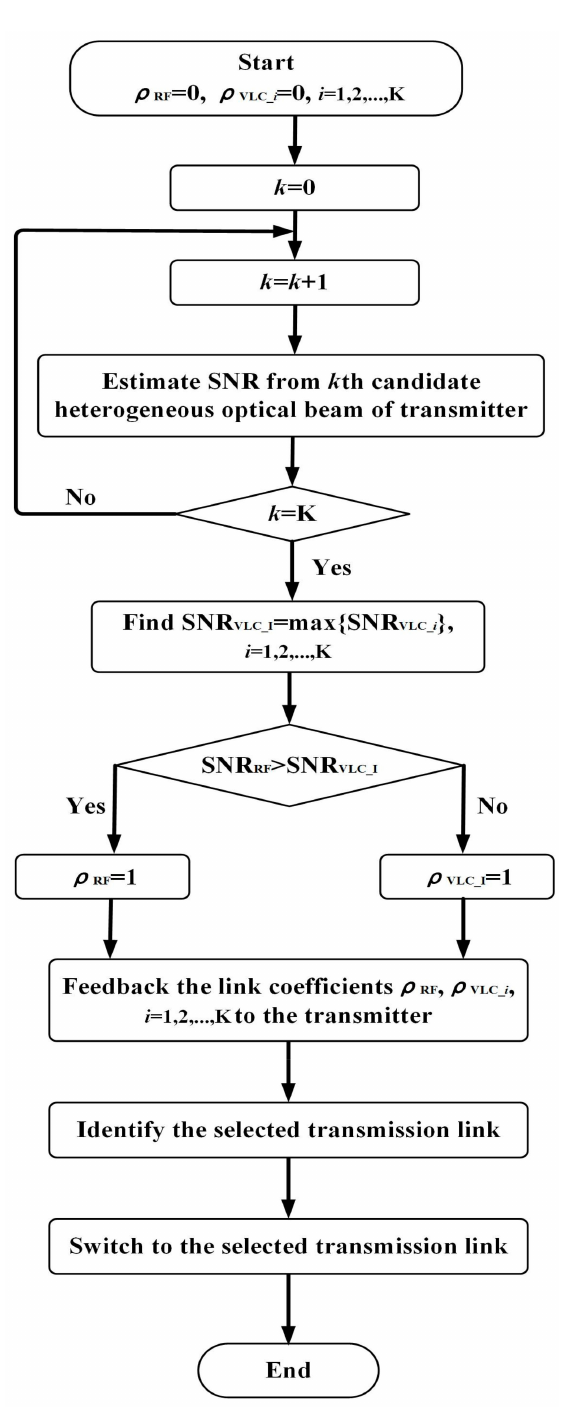
Figure 6. Flow chart for the operation mechanism of heterogeneous optical beams-based hybrid VLC/RF hard switching